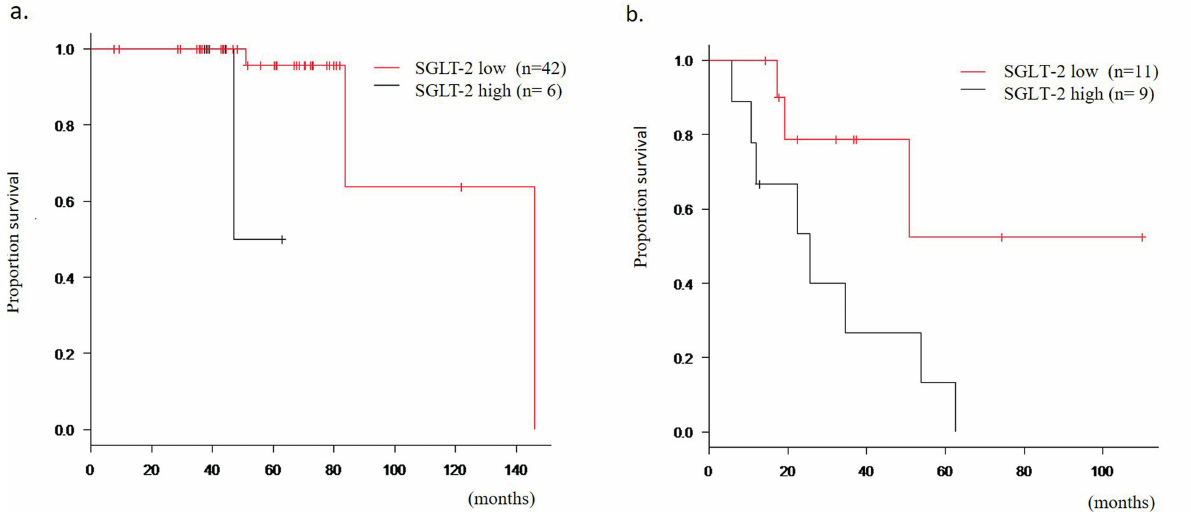
Figure 2 - Survival curves according to SGLT - 2 expression in Rcc tissue.